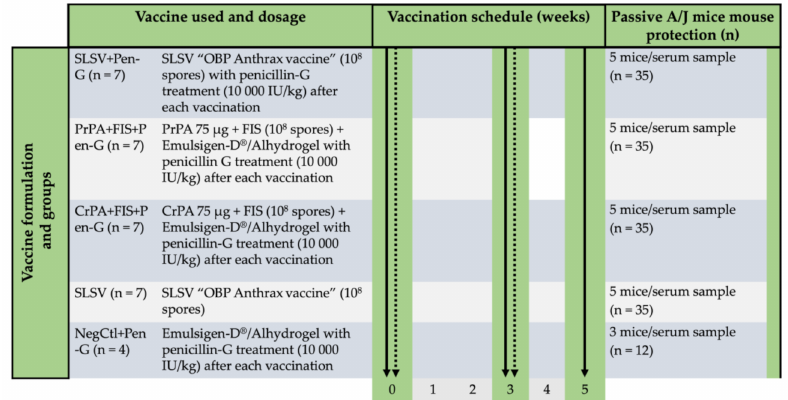
Figure 1. The timeline for two-step vaccination in cattle groups consisting of Sterne live spore vaccine (SLSV) with and without penicillin-G treatment and non-living anthrax vaccines with penicillin-G treatment followed by sera collection and passive mouse protection model. The passive mouse model consisting of A / J mice injected with purified polyclonal IgG from the sera of vaccinated cattle and challenged with Bacillus anthracis 34F2 spores. The thick continuous arrows show timepoints for sera collection and the dotted arrows indicate the vaccination timepoints. Sterne live spore vaccine: SLSV; Purified recombinant protective antigen: PrPA; Crude recombinant protective antigen: CrPA; Formalin inactivated Bacillus anthracis spores: FIS; Negative control: NegCtl; Penicillin-G: